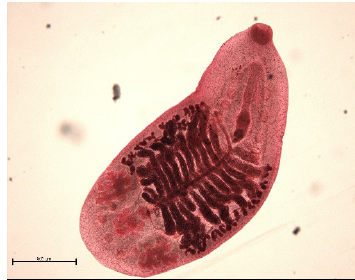
Figure 5. Notocotylus noyeri. There is no ventral sucker but there are three rows of ventral glands. Testes and ovary are situated at the posterior end. Branches of the uterus reach laterally to yolk glands. Bar: 500 μm.